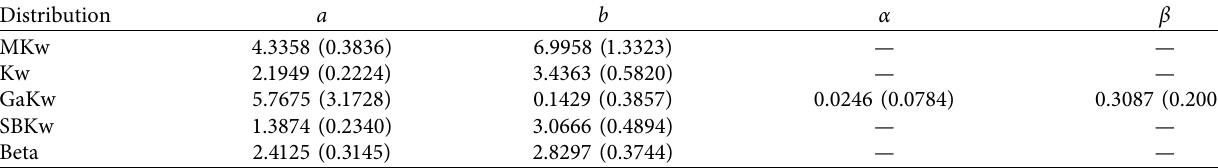
Table 9: MLEs and their standard errors (in parentheses) for data set 3.